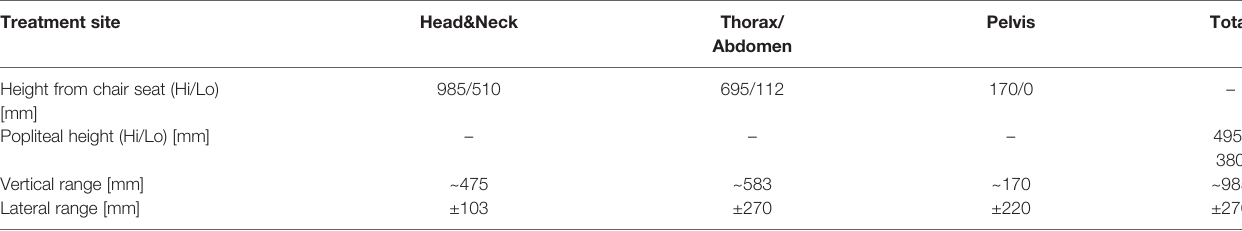
TABLE 1 | Requirements placed on a chair system for different treatment